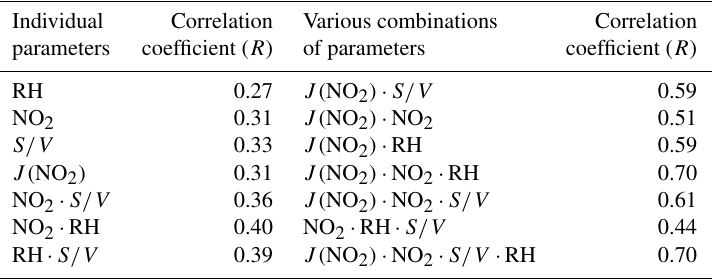
Table 3. Linear correlation coefficients (Pearson correlation, R ) of the unknown source to parameters related to HONO production. Individual Correlation Various combinations Correlation parameters coefficient ( R ) of